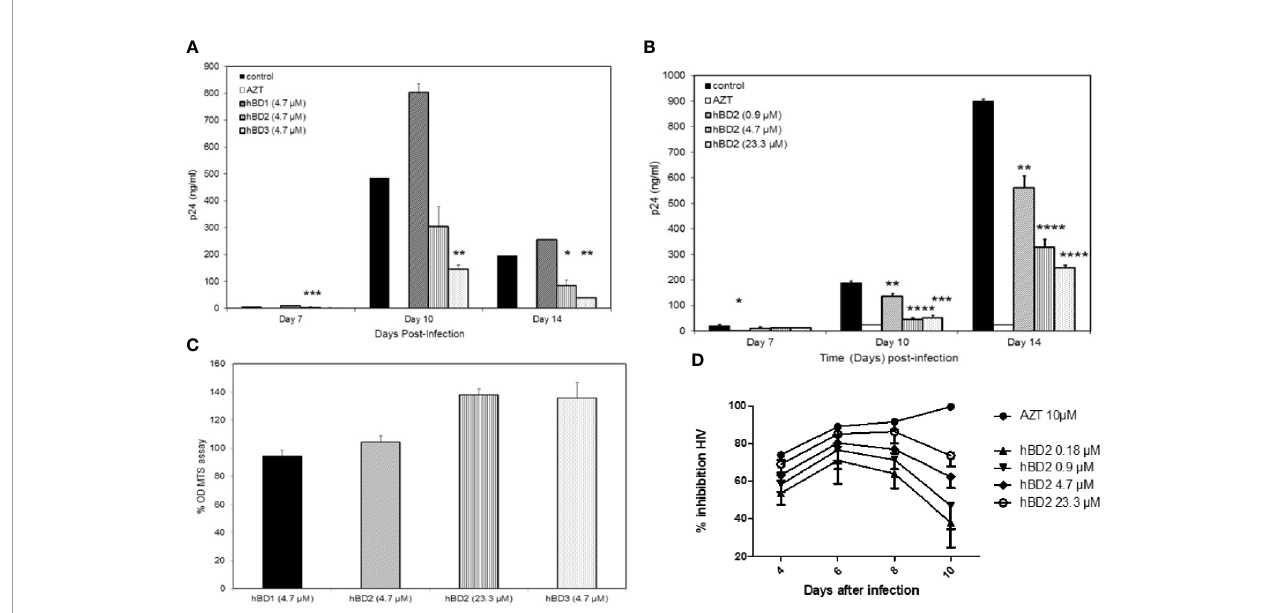
FIGURE 1 | Human b -defensins inhibit HIV-1 replication in macrophages in vitro . MDM were infected with HIV-1 BaL . After virus removal and washing, hBD1, hBD2, and hBD3 (4.7 µM) (A) or increasing concentrations of hBD2 (0-23.3 µM) (B) were added to cultures. Cells were pretreated with AZT as control. Infection was monitored by assaying supernatants for HIV p24 production by ELISA at the times indicated. Data are presented as mean ± SEM of triplicates. Representative experiment, n =3. *P < 0.05, **P < 0.005, ***P < 0.0005, ****P < 0.0001 between treatment and control groups determined with unpaired two-tailed t test. (C) ß-defensins are not toxic to macrophages at the concentrations that inhibit HIV-1. Cells treated with hBDs were tested using MTS assay. Cells were cultured in triplicate in 96-well plates for 3 days in the presence or absence of b -defensins; MTS mix was added and incubated 1 to 4 hrs prior to spectrophotometric absorbance readings at 490 nm. Triplicate readings were averaged (± SEM) and percentage OD ratios of treated/control cells were calculated. (D) hBD2 inhibit infection of MDM with a transmitted-founder HIV strain. MDM were infected with transmitter-founder virus AD17. After virus removal and washing, hBD2 at concentrations indicated above were added to cultures. HIV p24 release in supernatants was monitored by ELISA at the time indicated, and % inhibition was calculated as % of HIV p24 production from untreated MDM. Data are presented as mean ± SEM of triplicates,